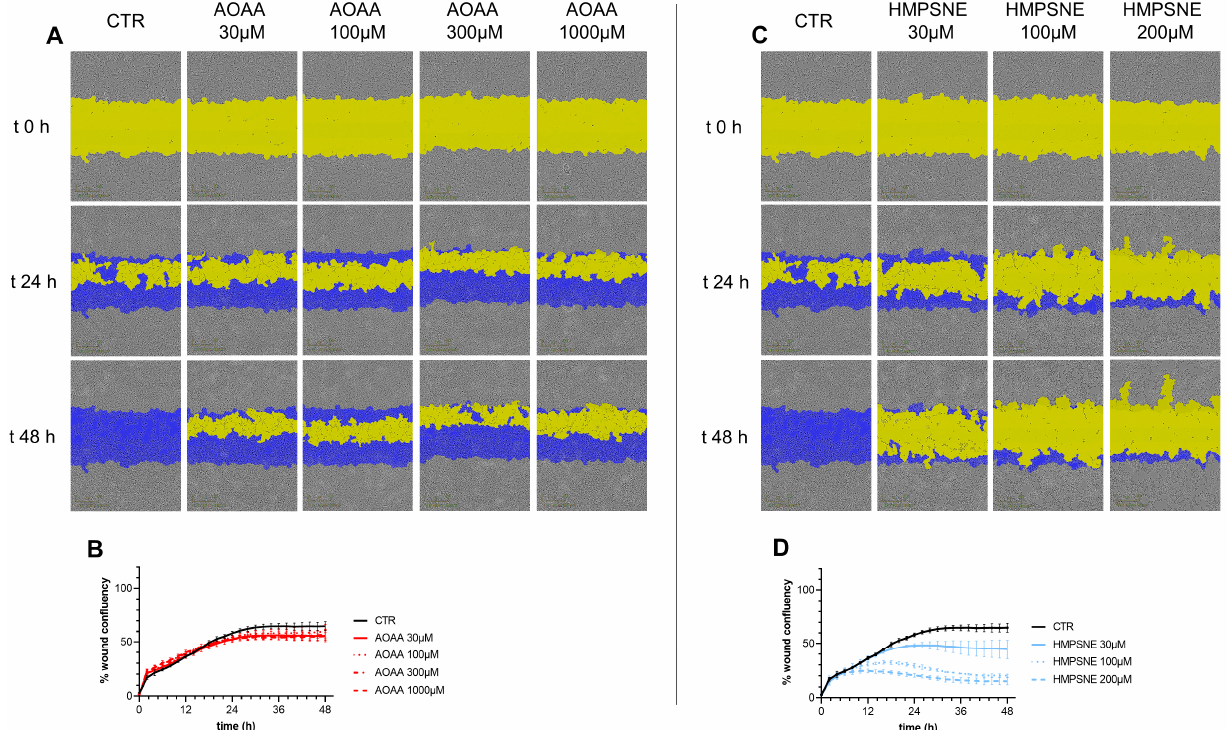
Figure 7. Effect of inhibition of H 2 S biosynthesis on EO771 cell migration. Cells were treated with various concentrations of AOAA ( A , B ) or HMPSNE ( C , D ). Images ( A , C ) show closure of the wound for up to 48 h post wounding. (Scratch wound mask in yellow, initial scratch wound mask in blue). Panels B and D show percent wound closure of EO771 cells treated with increasing concentrations of AOAA ( B ) or HMPSNE ( D ) over time; mean ± SEM values, N = 3. The effect of HMPSNE (all three concentrations tested) was statistically significant, p < 0.05.